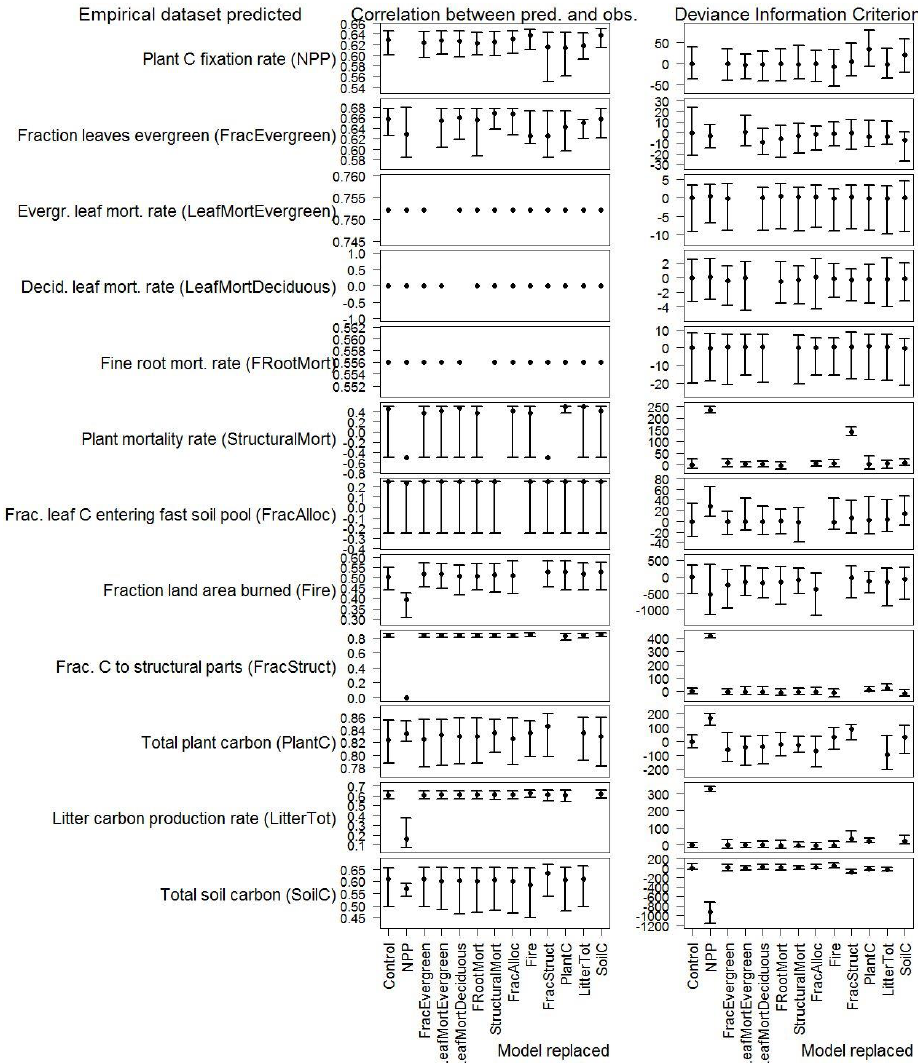
Fig. 8. Correlations between model predictions and hold-out evaluation data (left) and DIC values (right) obtained from different replace-null model fitting experiments. Confidence intervals and points have been removed where the empirical dataset predicted corresponds directly to the model replaced. This is because model performance for that component is typically very poor, making it difficult to visualise the performance of the other components. Points represent the average median estimate using the parameter probability distributions obtained from 10-fold model fitting, and the whiskers are average 95% confidence intervals. “Control” indicates the results obtained for the full model fitted to all data